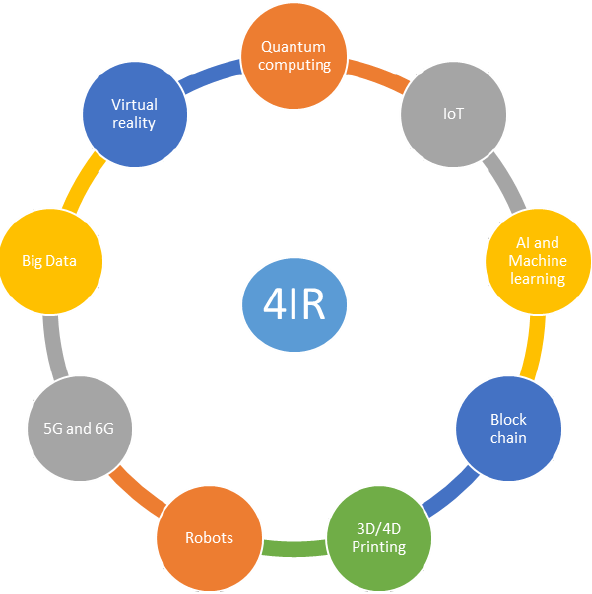
Figure 3. A graphical list of 4IR technology examples.